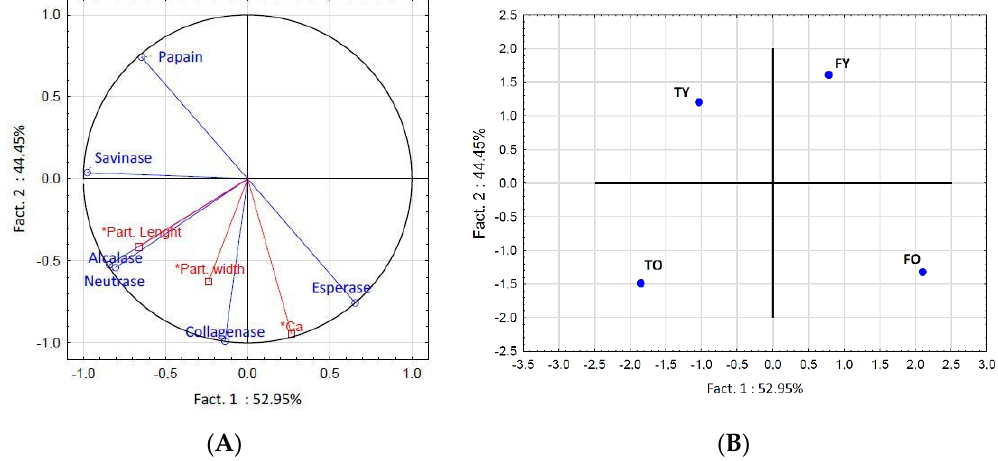
Figure 2. Principal component analysis (PCA) on collagen peptides concentration considering enzymes and particle size as variables ( A : loading plot) and bone age and anatomy as individuals ( B : score plot). FO = old femur, 10 years; TO = old tibia, 10 years; FY = young femur, 4.5 years; TY = young tibia, 4.5 years.